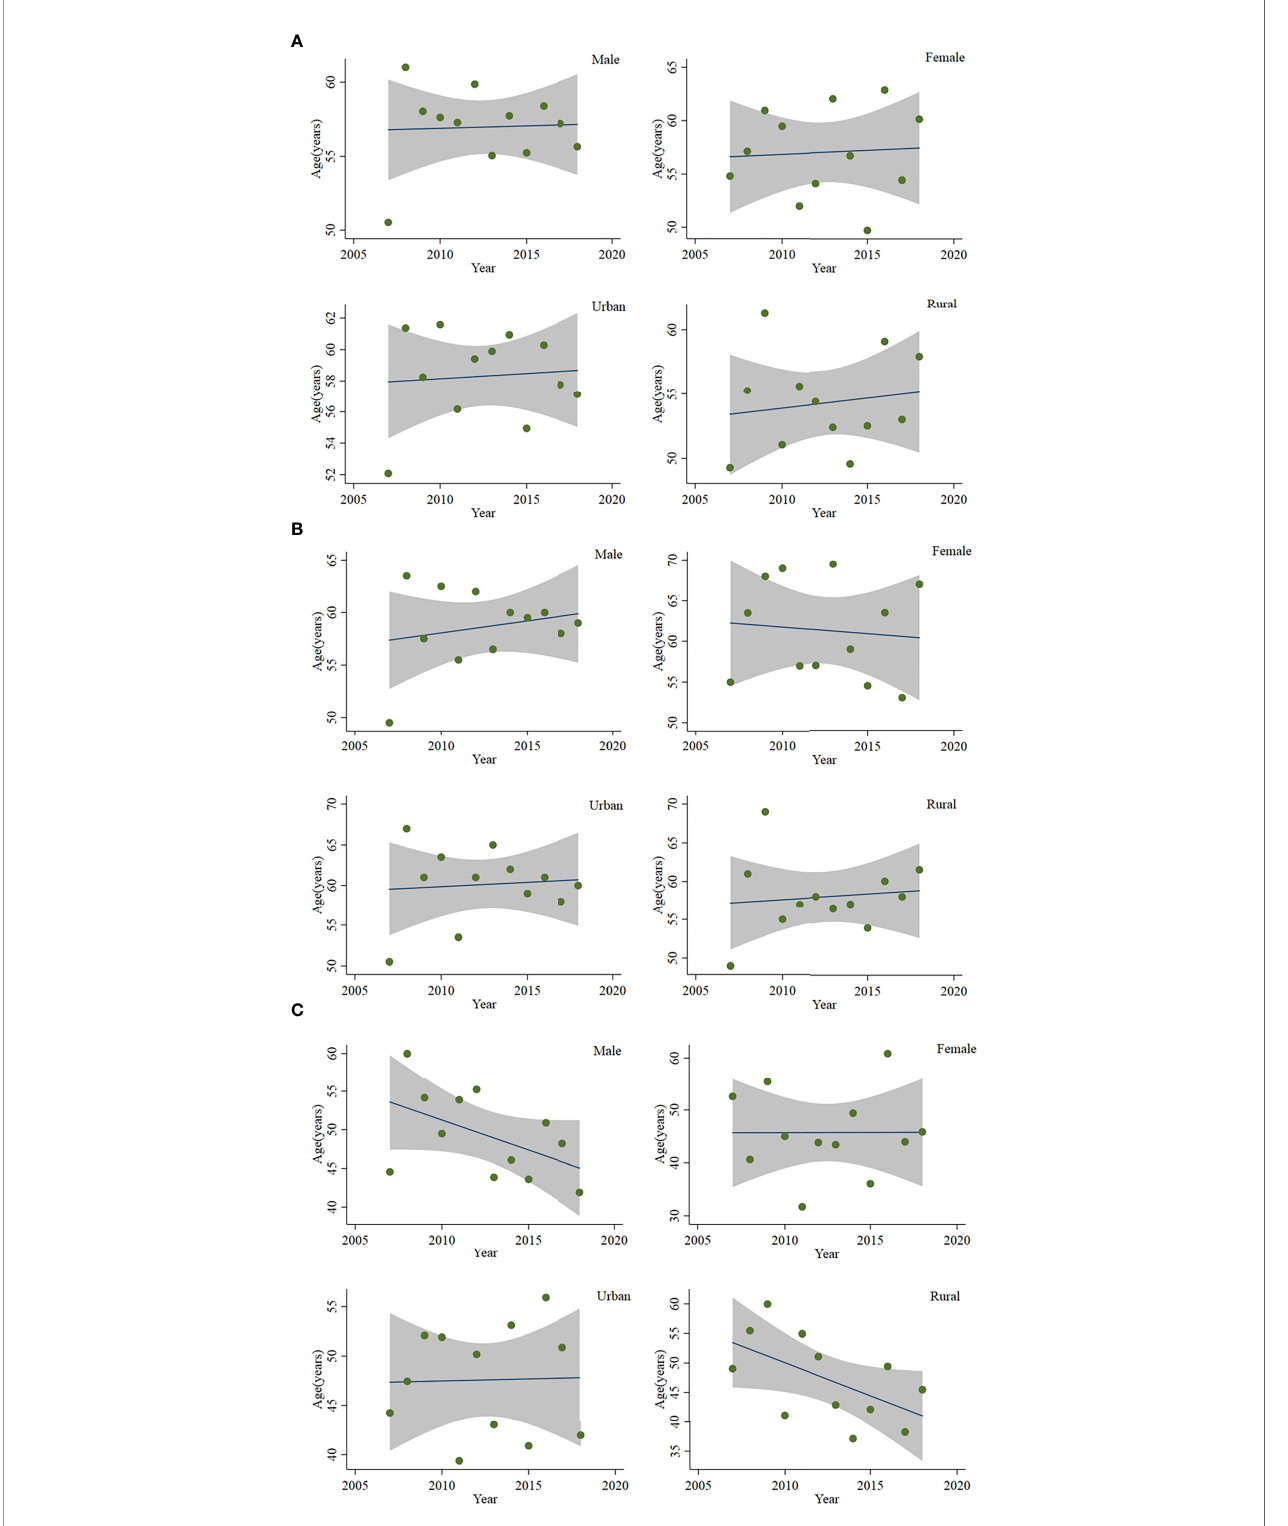
FIGURE 4 | Age of onset of patients with peripheral T-cell lymphoma in Beijing from 2007 to 2018: (A) mean age of onset, (B) median age of onset, and (C) standardized mean age of